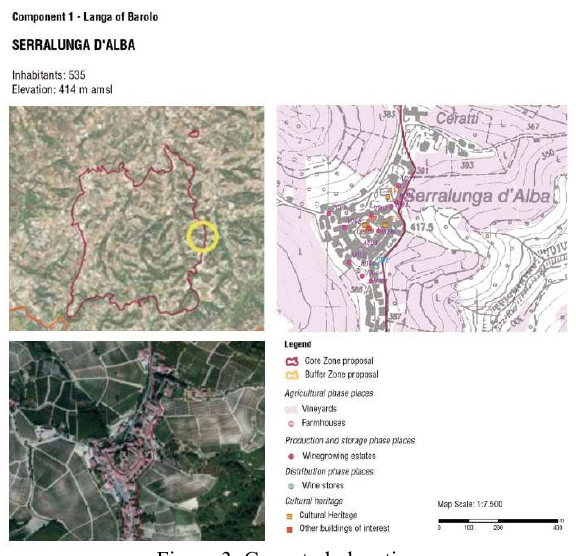
Figure 3. Case study location